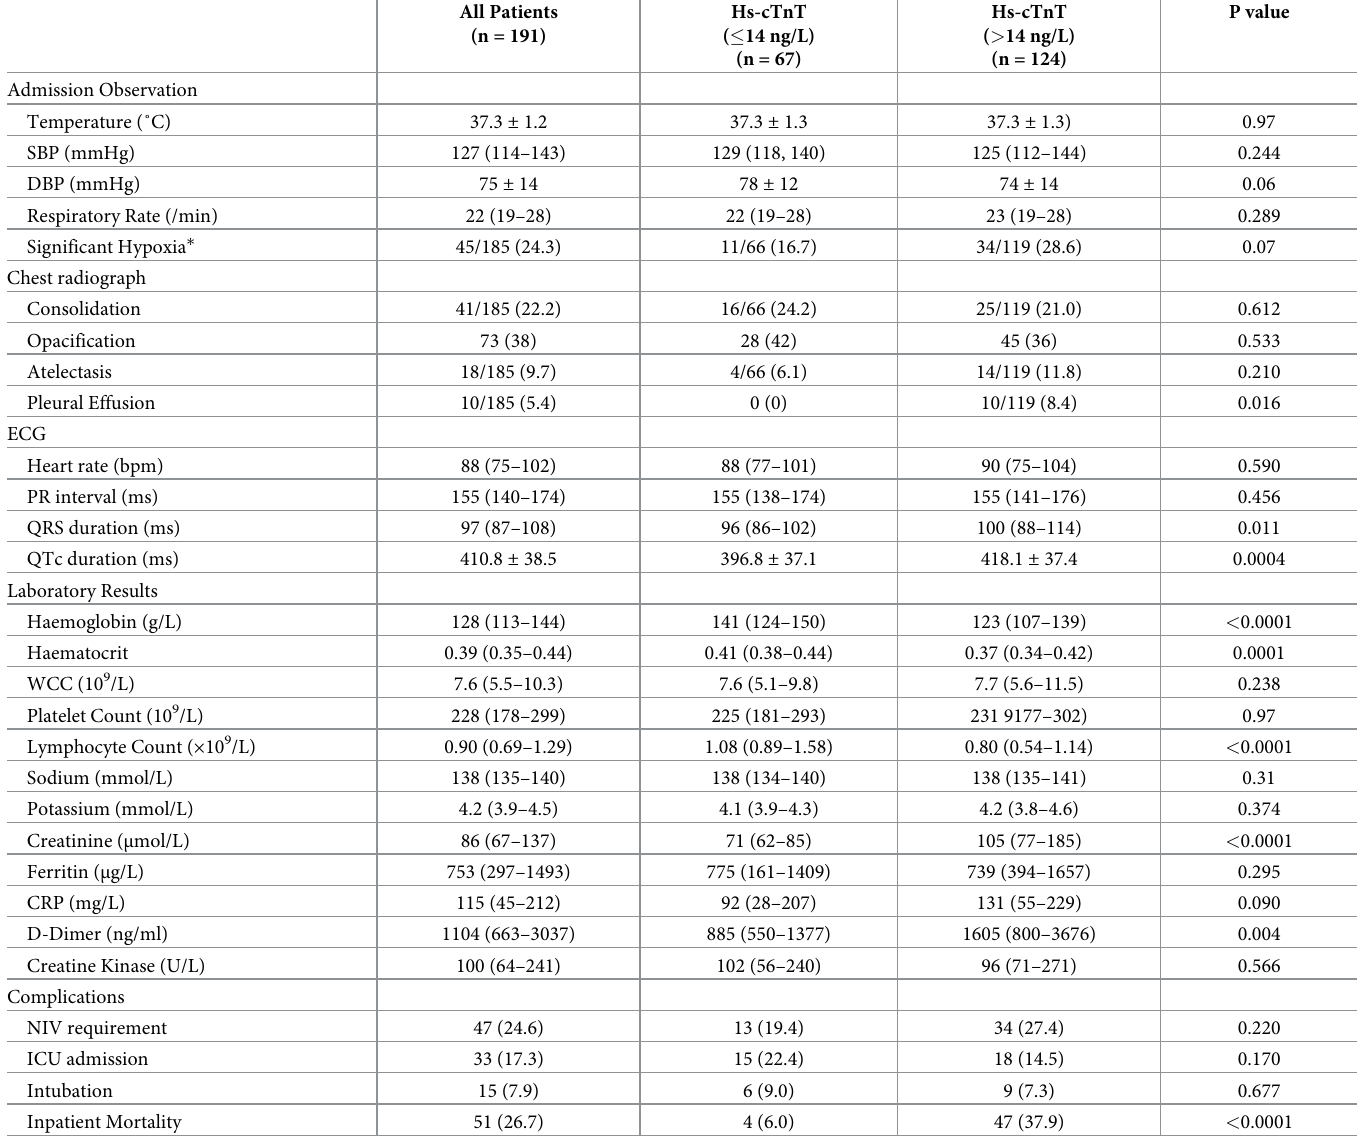
Table 2. Patient observations, investigation results and